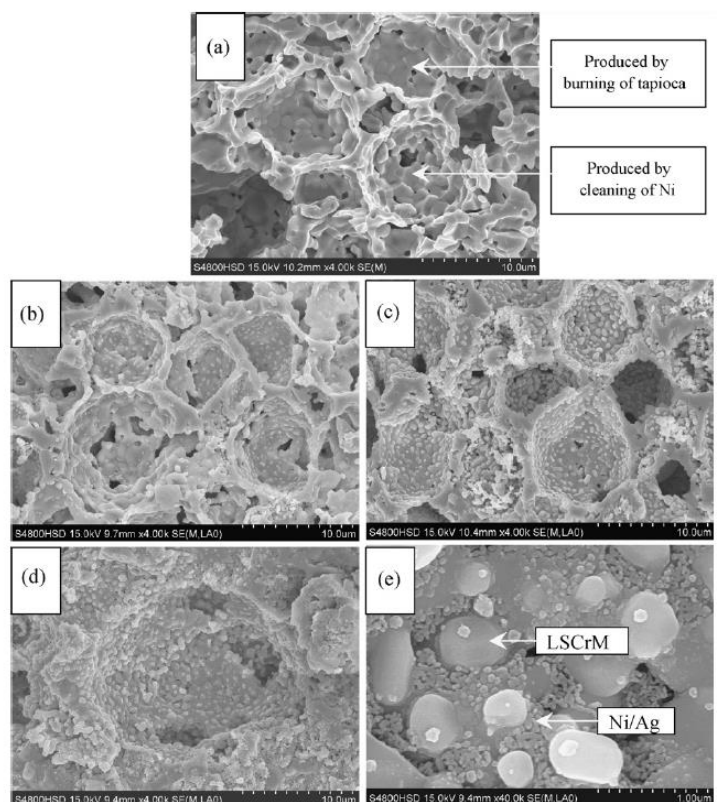
Figure 5. SEM micrographs of the cross-sections of: ( a ) pure YSZ anode backbone; ( b ) ∼ 5 wt.% LSCrM-impregnated YSZ anode; ( c ) ∼ 35 wt.% LSCrM-impregnated YSZ anode; ( d , e ) LSCrM/Ni/Ag ( ∼ 32/6/2 wt.%) impregnated YSZ anode [33].